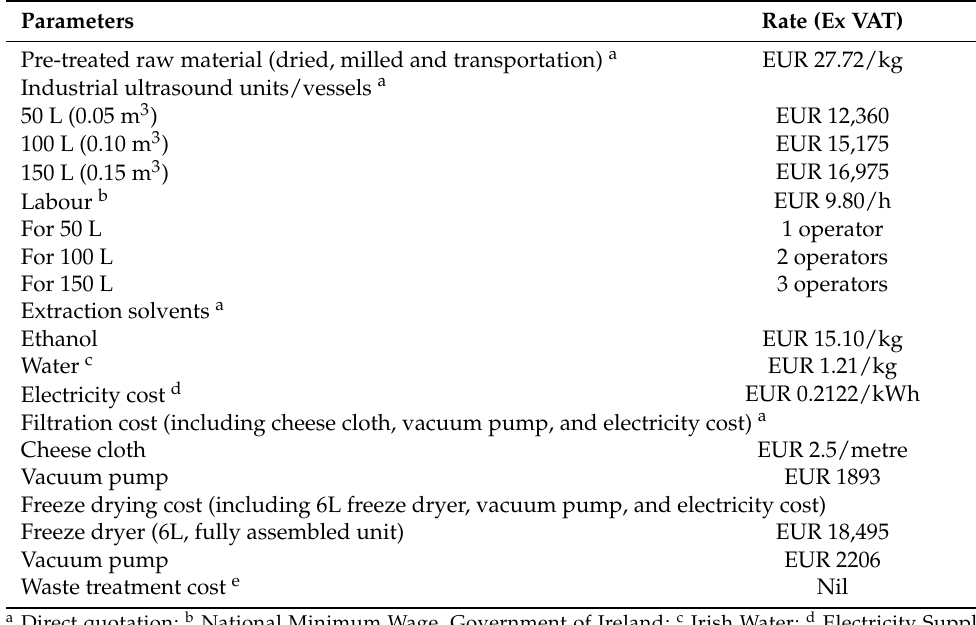
Table 2. Economic parameters used for cost of manufacturing (COM)